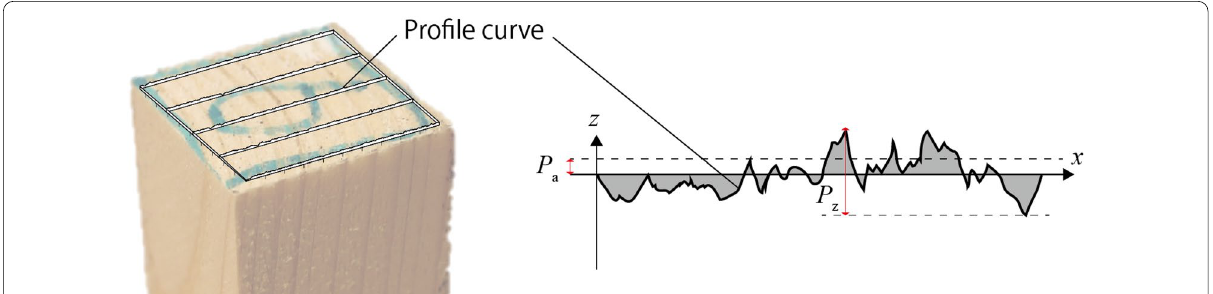
Fig. 14 Typical surface profile and profile